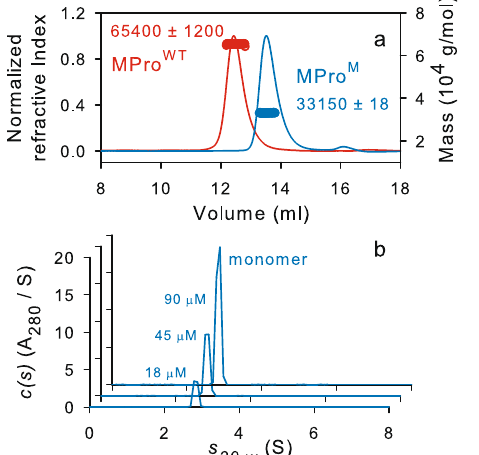
Fig. 2 Molecular mass estimation of MPro M . a Mass estimation by SEC- MALS by injecting 125 µ L of MPro M and MPro WT at ~58 µ M and 30 µ M, respectively. b SV-AUC absorbance c(s) distributions at concentrations ranging from 18 to 90 µ M of MPro M . SEC-MALS and SV-AUC were carried out in buffer A at 25 °C.